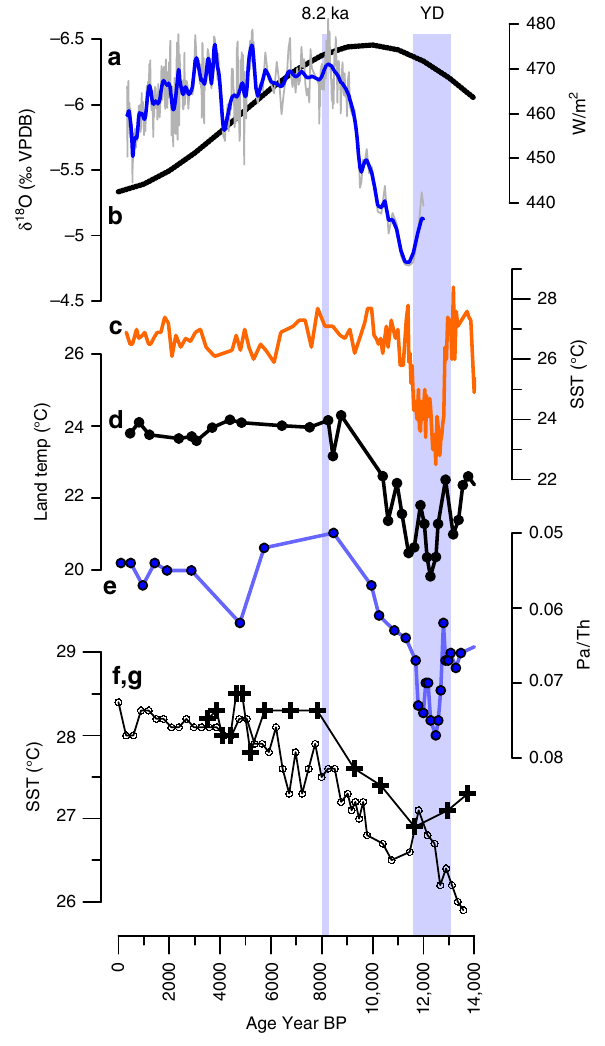
Fig. 3 Ocean – atmosphere linkages to the Holocene rainfall increase. Comparison of a the Guatemala speleothem GU-RM1 precipitation proxy with b 15°N July 21 insolation, c sea-surface temperature (SST) in the Cariaco Basin from Mg/Ca proxy 57 , d the inferred land surface temperature for the Petén region of Guatemala from pollen in Lake Petén Itza sediments 7 , and e the Pa/Th ratio 70 , a proxy for the strength of the Atlantic Meridional Overturning Circulation (AMOC), f the SST near Grenada 33 (gray line with circles), and g Caribbean SST 32 (black line with